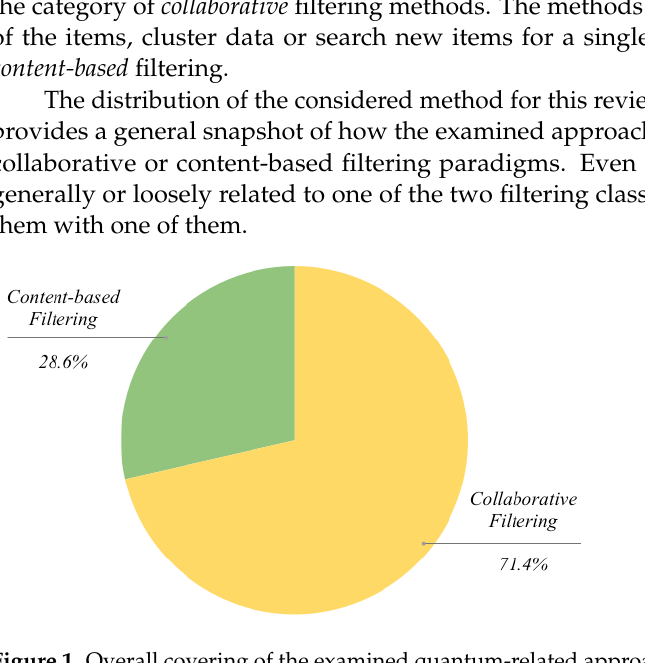
Figure 1. Overall covering of the examined quantum-related approaches with regard to a subdivision related with collaborative- vs. content-based